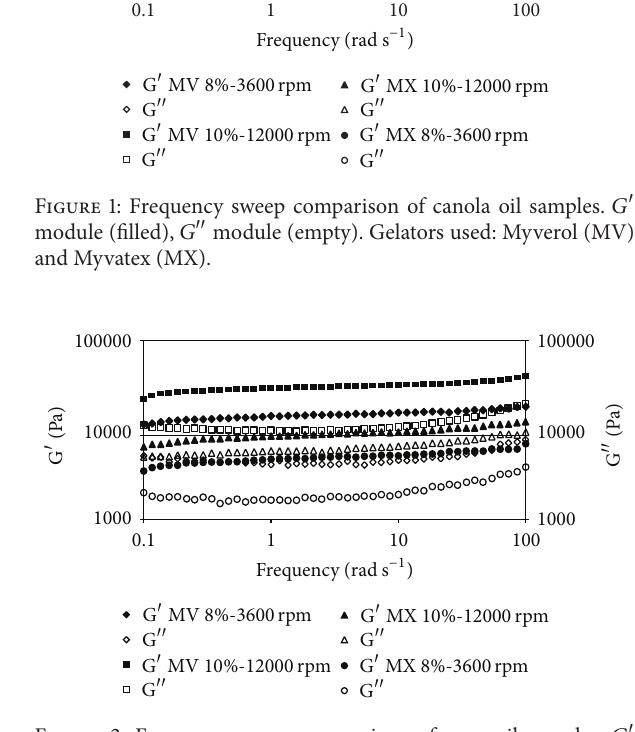
module (filled), 𝐺 󸀠󸀠 module (empty). Gelators used: Myverol (MV) and Myvatex